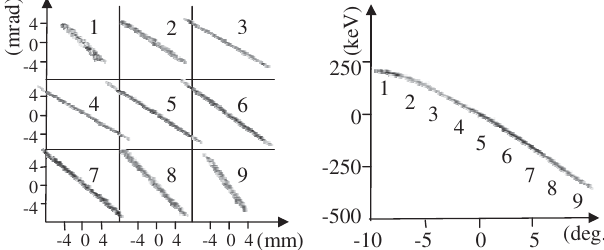
FIG. 9. (Color) Transverse slice phase-spaces (left) and longitu- dinal slice phase-space (right) at the solenoid’s exit in the example discussed in Sec. VI with (cid:9)